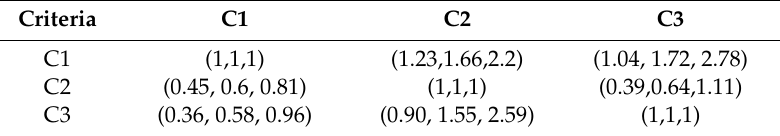
Table 11. Fuzzy geometric mean of weights / preferences.